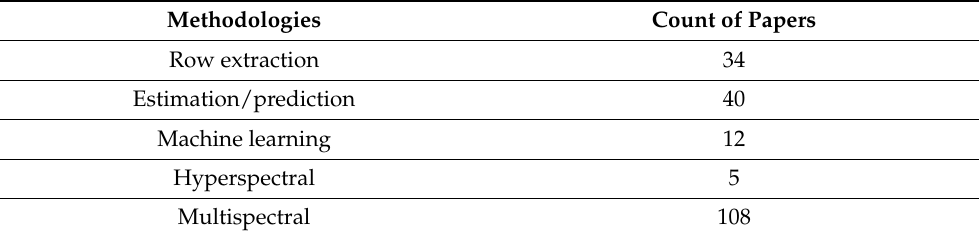
Table 5. Methodologies applied in